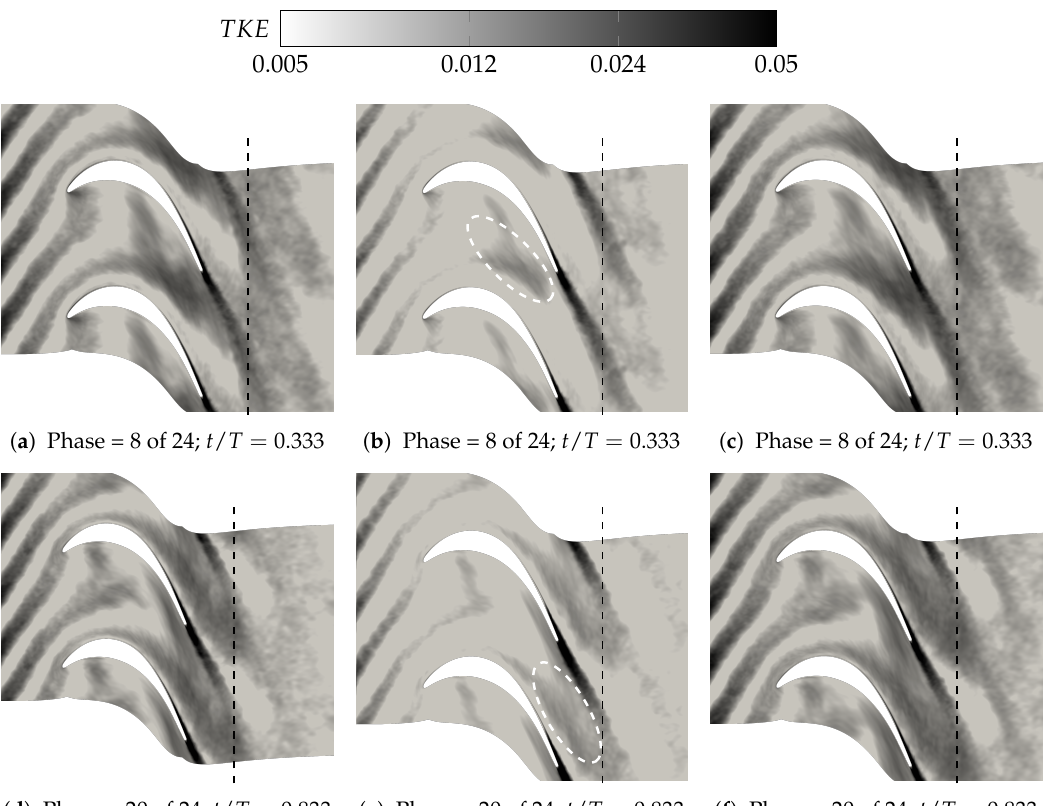
Figure 3. Phase-lock averaged turbulent kinetic energy ( TKE ) at different phases for the non-rotating bar case R 0 ( a , d ), the counter-clockwise rotating bar case R 1 ( b , e ) and the clockwise rotating bar case R − 1 ( c , f